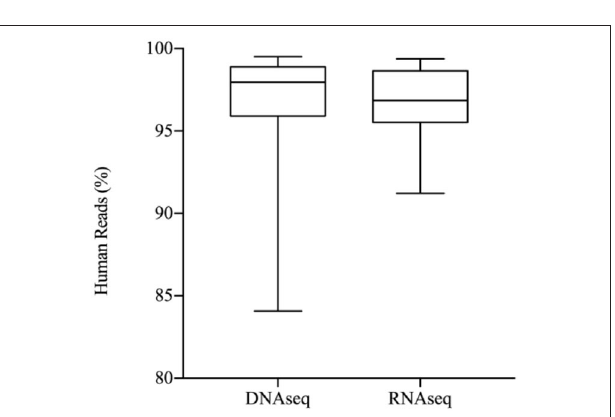
FIGURE 2 | Host background of sequencing